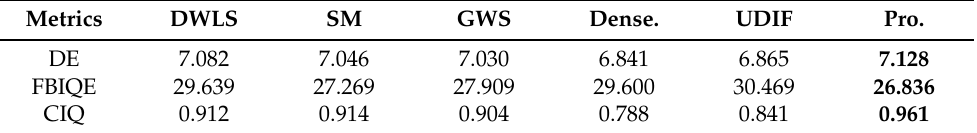
Table 1. Performance comparison between GWS [1], DWLS [11], SM [8], DenseFuse [17], UDIF [20], and the proposed